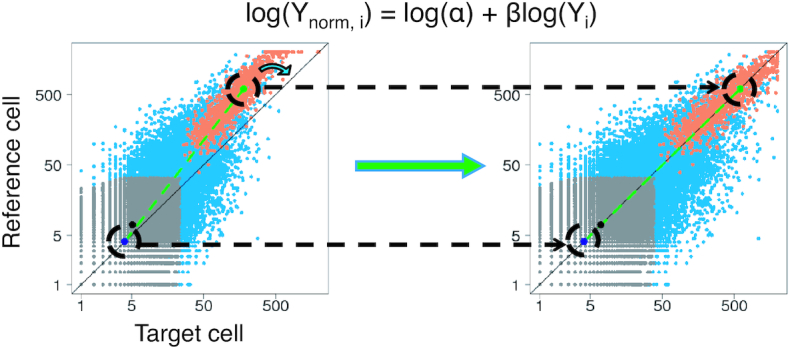
Overview of the S3norm method. The graphs present scatterplots of read counts (log scale) in 10,000 randomly selected genome locations (200 bp) in target cell (x-axis) and reference cell (y-axis). The left figure is the signal before S3norm. The right figure is the signal after S3norm. The S3norm applies a monotonic nonlinear model (\documentclass[12pt]{minimal}
\usepackage{amsmath}
\usepackage{wasysym}
\usepackage{amsfonts}
\usepackage{amssymb}
\usepackage{amsbsy}
\usepackage{upgreek}
\usepackage{mathrsfs}
\setlength{\oddsidemargin}{-69pt}
\begin{document}
}{}${\rm{log}}( {{{\rm{Y}}_{{\rm{norm}},{\rm{\ i}}}}} ) = {\rm{log}}( {\rm{\alpha }} ) + {\rm{\beta log}}( {{{\rm{Y}}_{\rm{i}}}} )$\end{document}) to rotate the target signal so that (i) the mean signals of common peaks (green point, highlighted by black dash circle) and (ii) the mean signals of common background (dark blue point, highlighted by black dash circle) can be matched between the two data sets. The original data were split into three groups: the common peak regions (orange), the common background regions (gray) and the remaining bins (blue). The overall mean is represented by a black point.